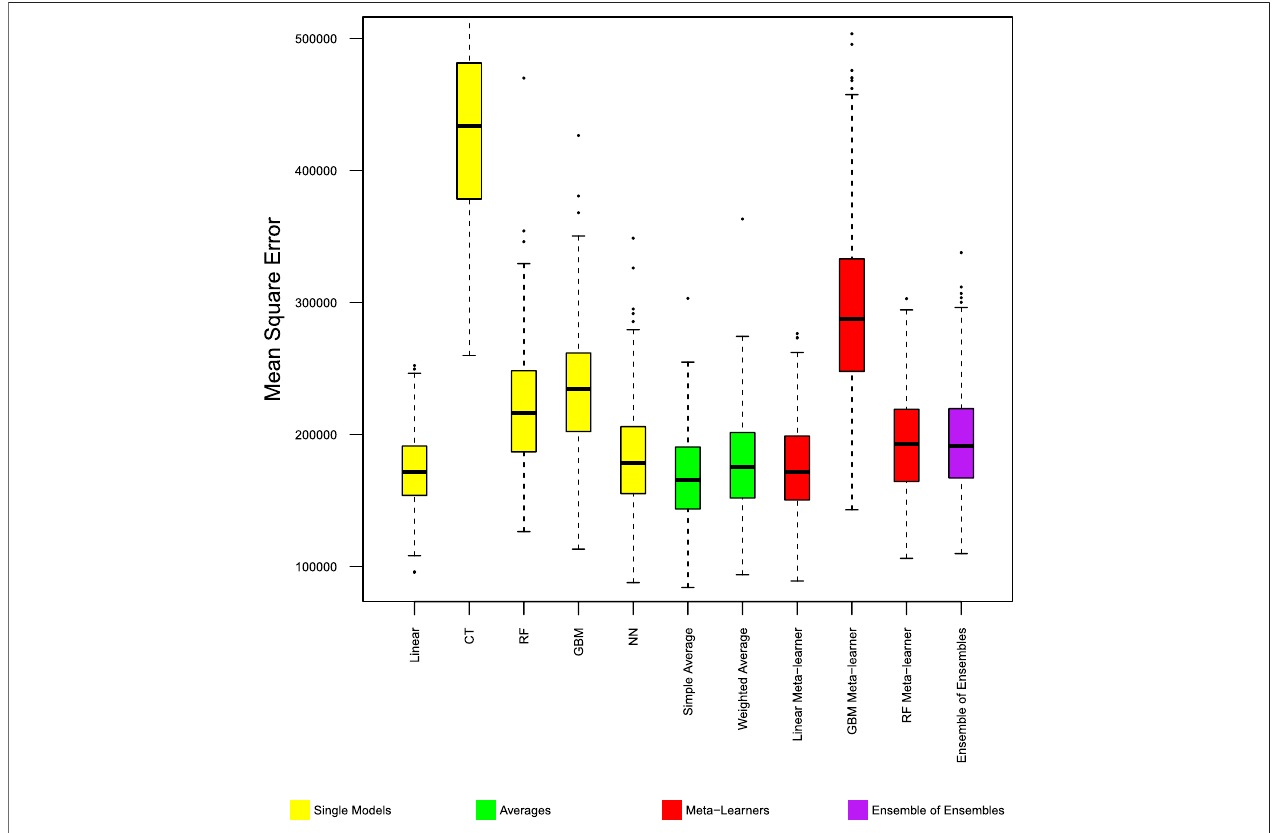
FIGURE 5 | Model performance in predicting trip production - NYC MSE. Distribution of mean square error from 400 experiments. Base models exclude the classi fi cation tree.